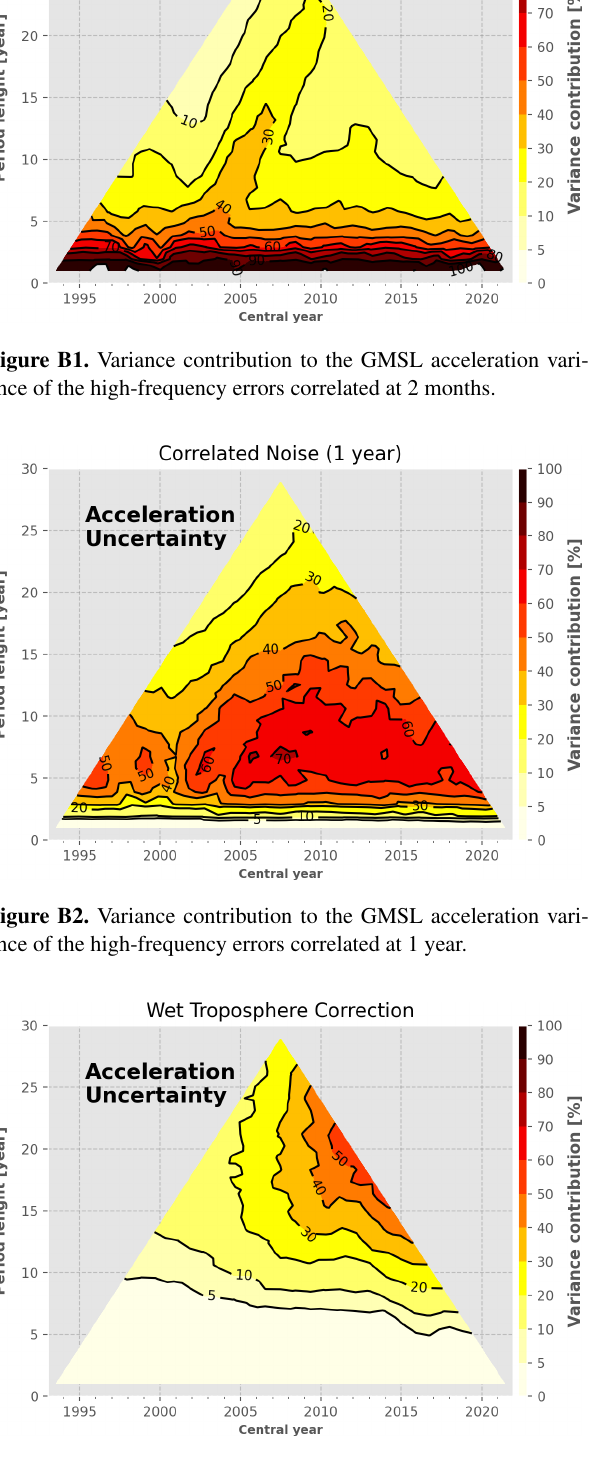
Figure B3. Variance contribution to the GMSL acceleration vari- ance of the WTC from radiometers.